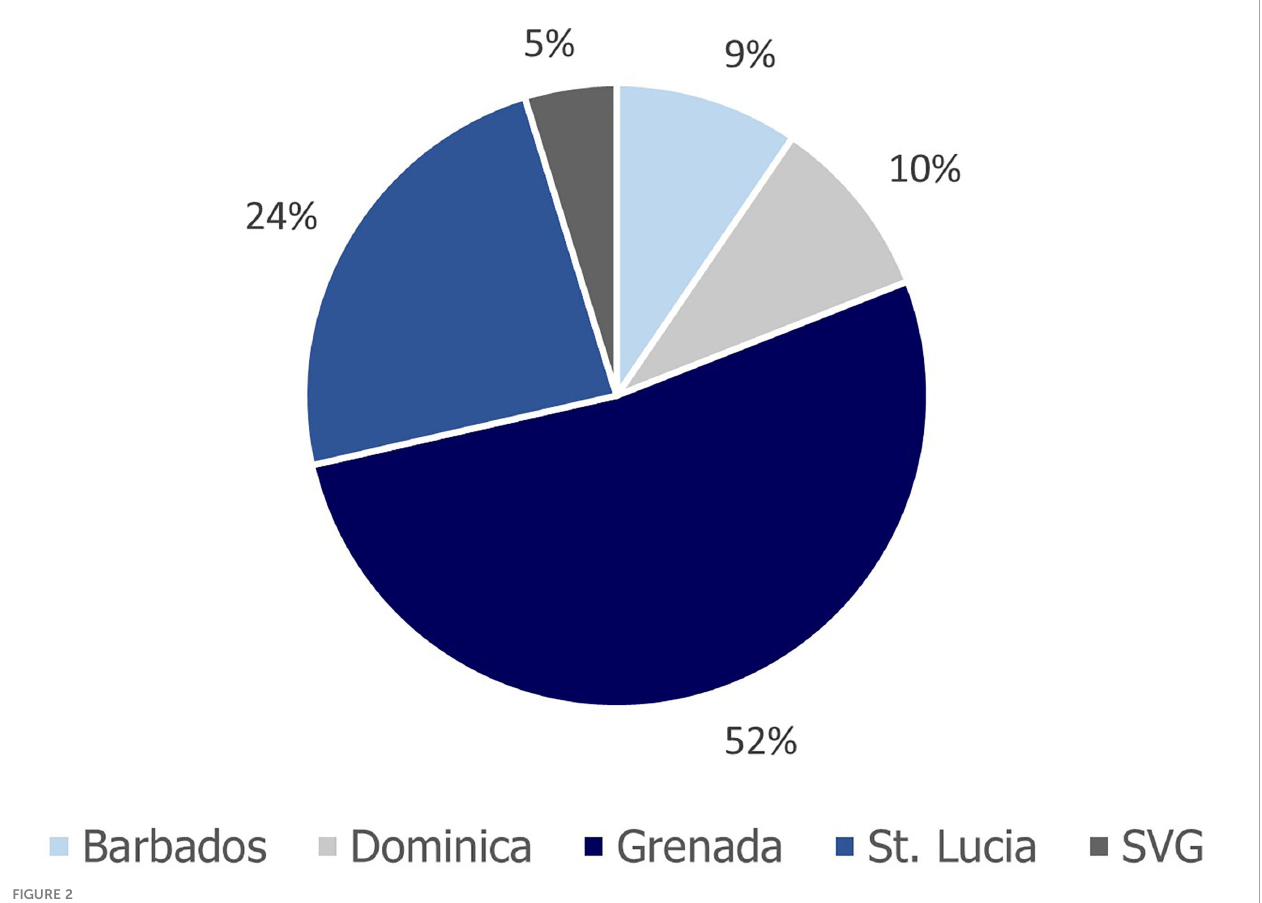
FIGURE 2 Participants by